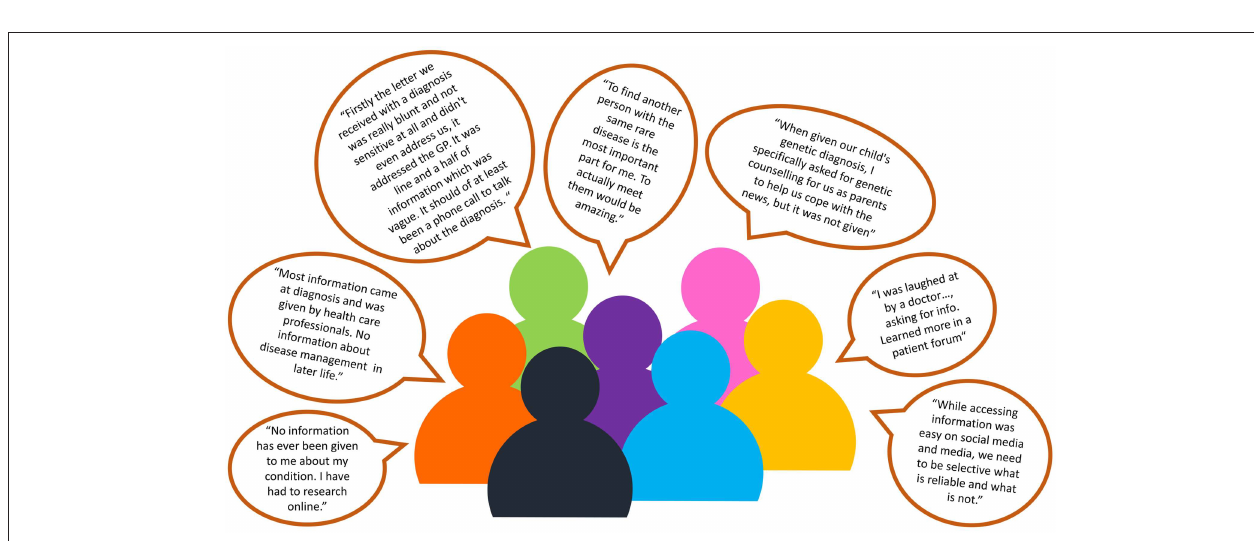
FIGURE 3 | Quotes from participants in the information and communication survey demonstrating the voice of the rare disease community in Northern